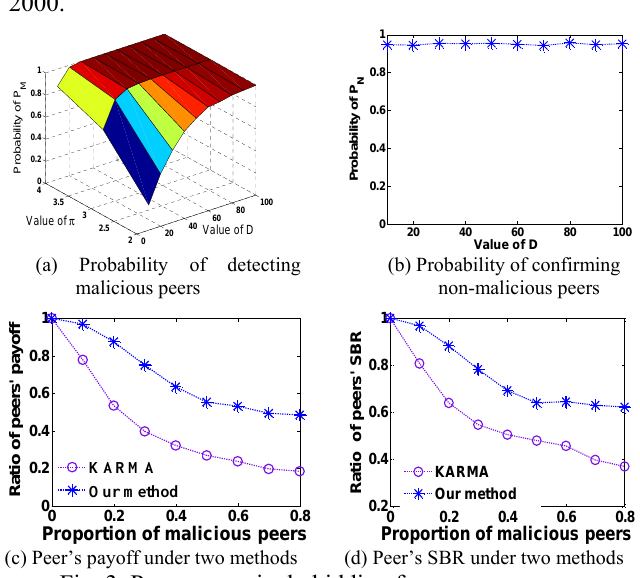
Fig. 3. Peers excessively bidding for